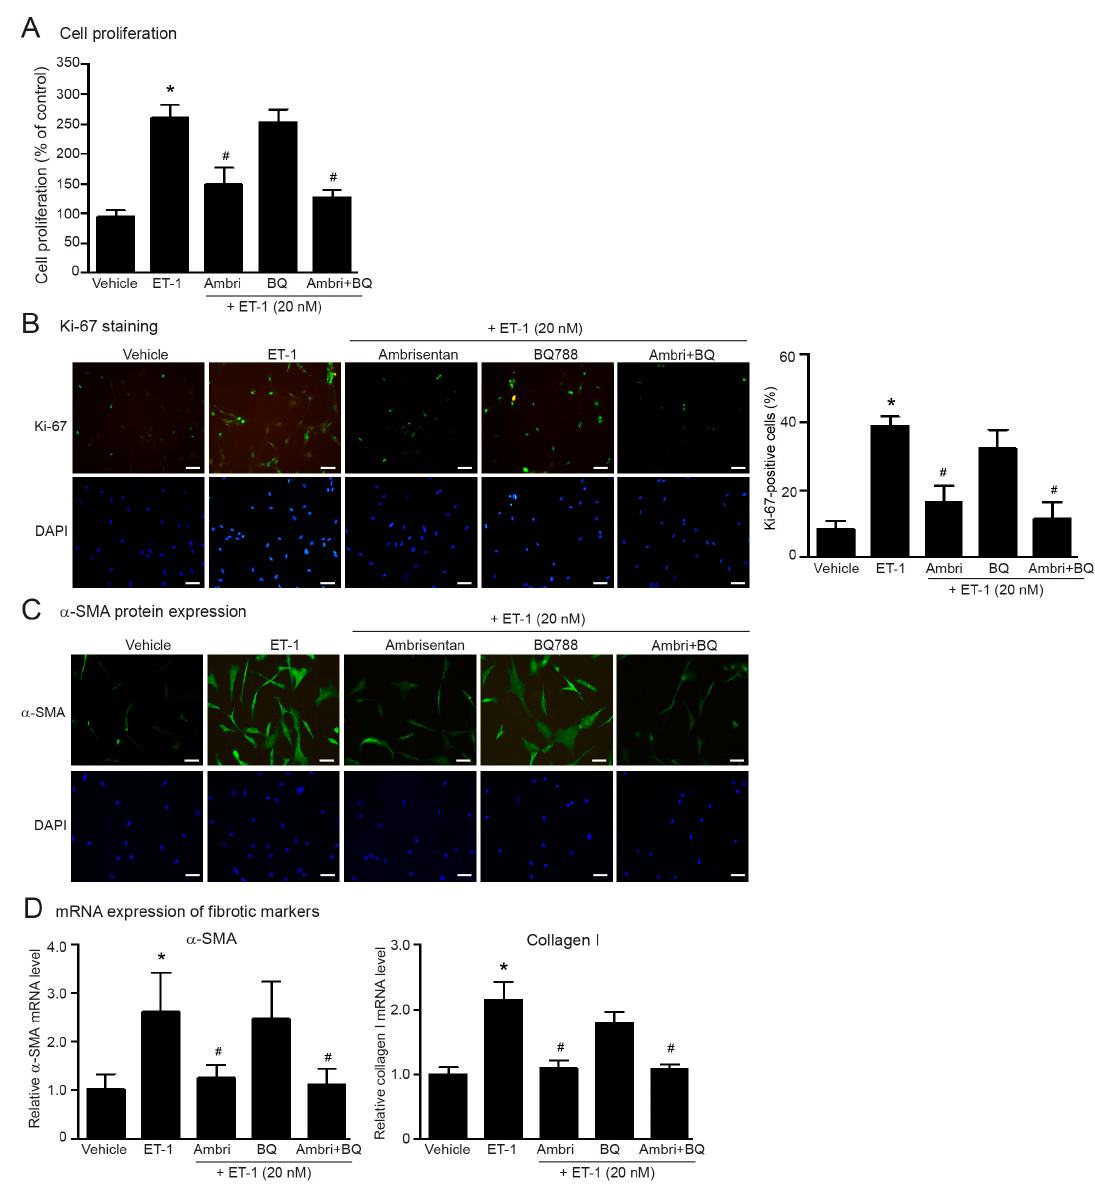
Figure 2. ET-1 induced cell proliferation and overexpression of myofibroblast markers through the ET A R subtype. Cells were pretreated without or with ambrisentan (ET A R antagonist; 1 µ M), BQ-788 (ET B R antagonist; 1 µ M) or ambrisentan plus BQ-788 for 1 h before treatment with ET-1 for 24 h ( A – C ) or 12 h ( D ). ( A ) Cell proliferation was calculated as percentage relative to control group. ( B ) Cells were stained for Ki-67 (green) and nucleus DAPI (blue). Scale bar, 10 µ m. Proliferative capacity was calculated as the percentage of Ki-67-positive cells. ( C ) α -SMA protein expression was visualized by fluorescent microscope. Cells were stained for α -SMA (green) and nucleus DAPI (blue). Scale bar, 10 µ m. ( D ) Relative α -SMA and collagen I mRNA levels analyzed by qRT-PCR were calculated as the fold over the vehicle-treated group. Data were expressed as the mean ± SD. ( n = 4). * p < 0.05 vs. vehicle; # p < 0.05 vs. ET-1.